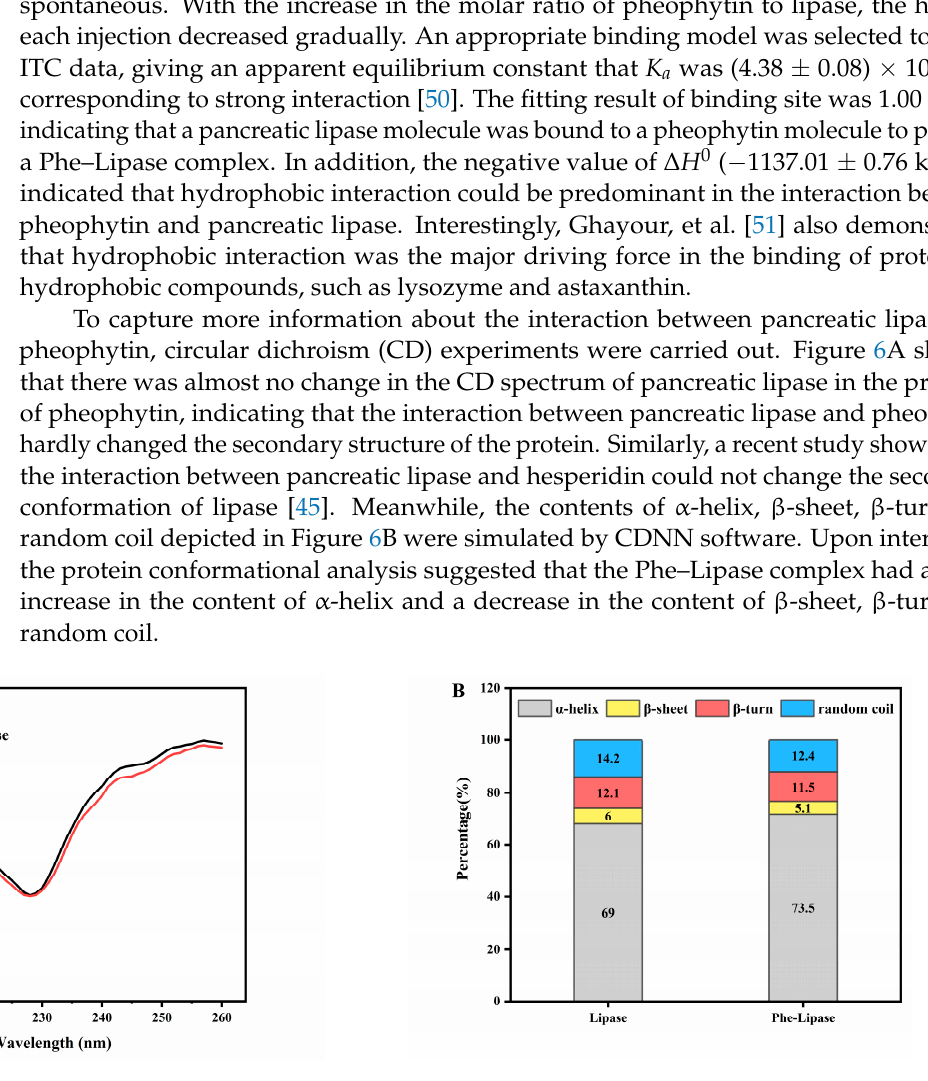
Figure 7. Conformational analysis of molecular docking results for pheophytin and pancreatic li- pase. The structure of pheophytin was drawn as sticks, while the structure of lipase was drawn as the surface. The hydrophilic and hydrophobic groups of pancreatic lipase were painted cyan and